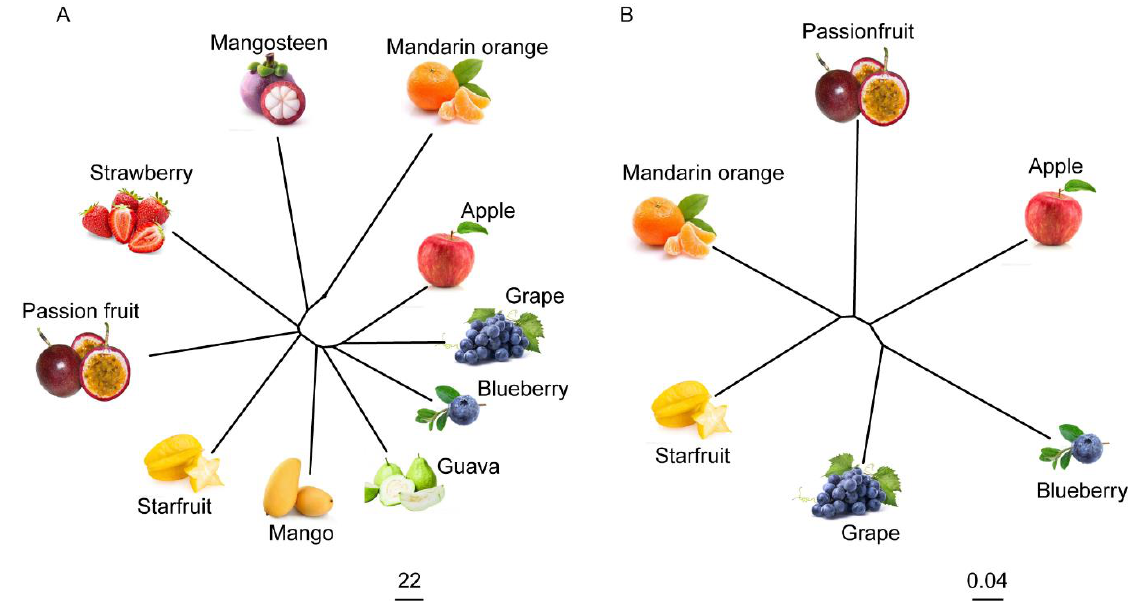
Figure 6. Phylogenomic relationships of different kinds of fruits. ( A ) The neighbor-joining tree of the ten fruit species with metabolome data. The scale bar indicates the simple matching distance. ( B ) The phylogenomic analysis of six fruit species. A phylogenetic tree was constructed using the single-copy protein data of passion fruit, apple, blueberry, grape, starfruit, and mandarin orange. The scale bar indicates the simple matching distance.